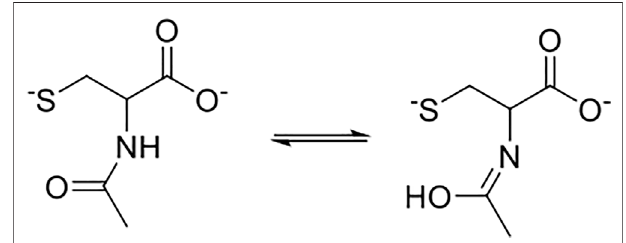
FIGURE 7 | Possible tautomeric equilibrium for N-acetylcysteine and glutathione compounds.